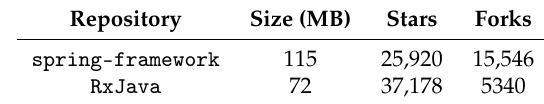
Table 1. Properties of the repositories used for creating project-specific datasets, as of January